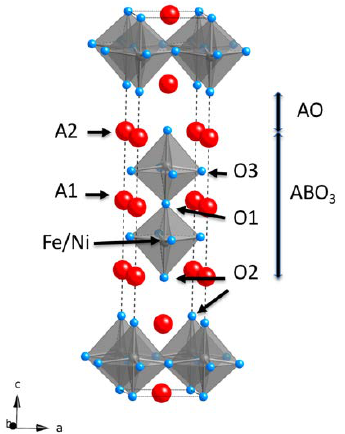
Figure 1. The crystal structure of a n = 2 A 3 (Fe,Ni) 2 O 7 Ruddlesden–Popper (RP) phase.